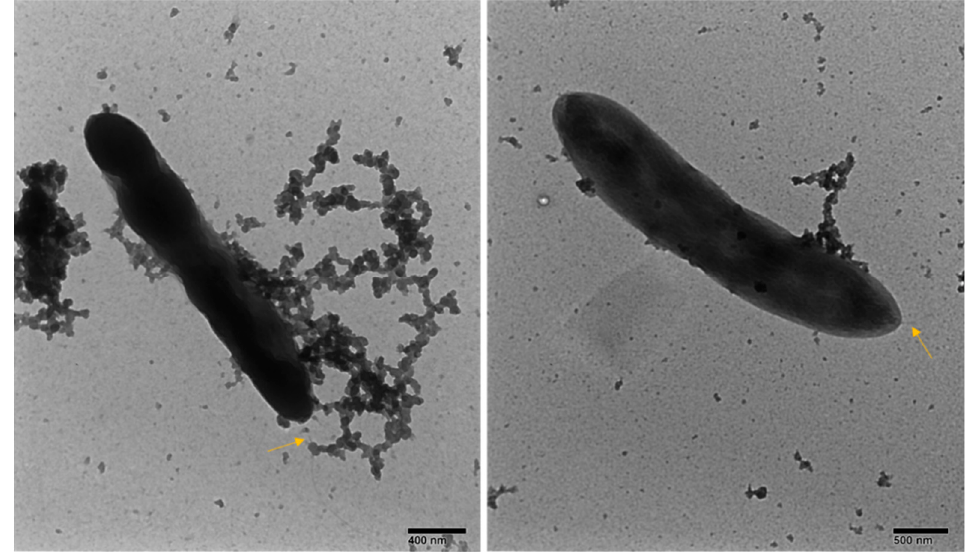
Figure 2. Negative staining electron microphotographs of isolated C. vaccinii -pigmented strain ( left ) and unpigmented strain ( right ). The arrow shows the flagellum of bacteria.